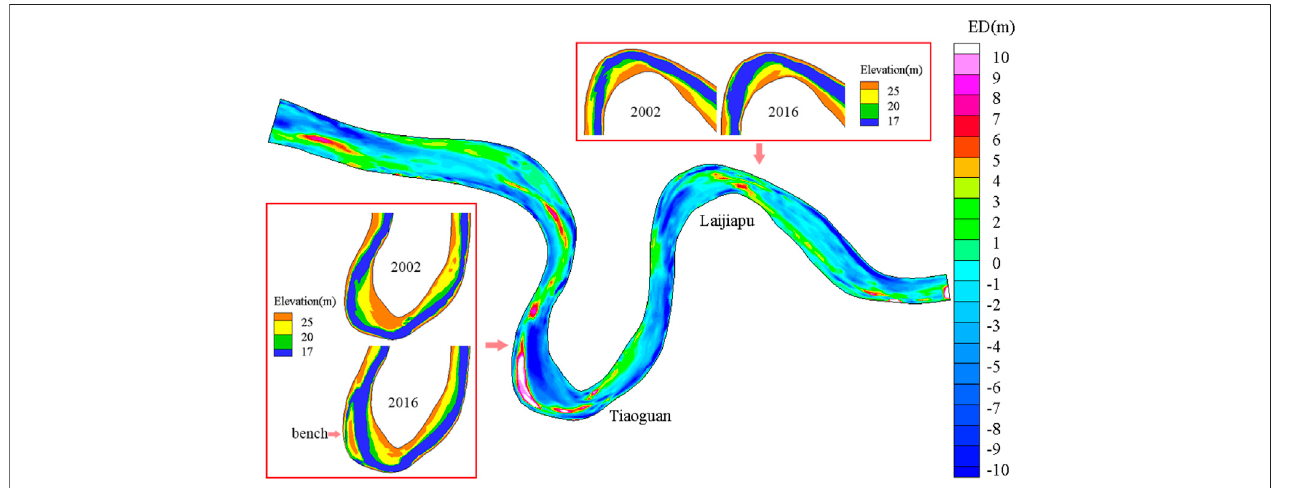
FIGURE 10 | Morphological changes of the Bend A and Bend B after the TGP operation. ED represents the depth of erosion and deposition.